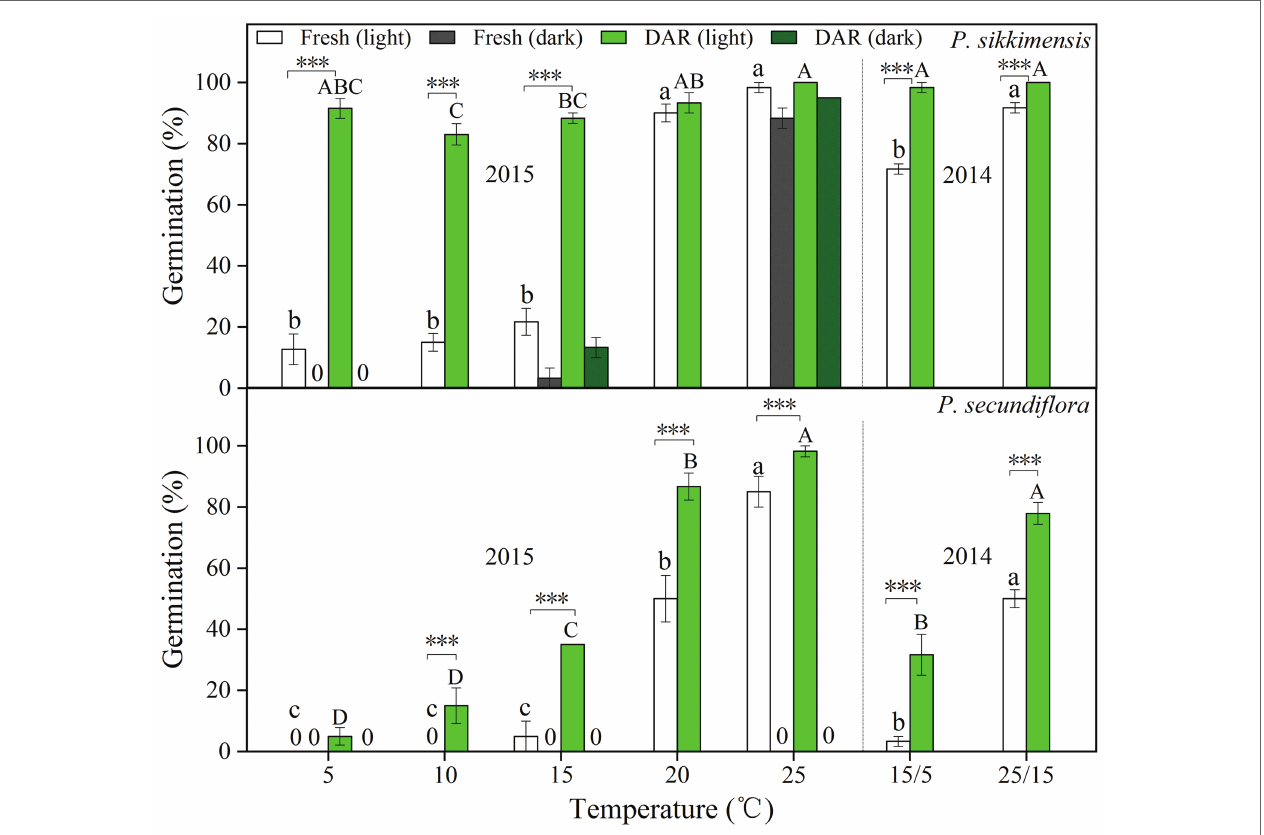
FIGURE 1 | Final germination percentages in light and dark at two alternating temperatures (15/5 and 25/15 ° C) in 2014, and five constant temperatures (5, 10, 15, 20, and 25 ° C) in 2015 for fresh and dry after-ripening (DAR) seeds of Primula secundiflora and Primula sikkimensis . Error bars indicate SE for three replicates of 20 seeds. 0, no germination with this treatment. Temperatures, dry after-ripening, and light treatments are statistically significant ( p < 0.001 by GLM) in these two species. Post hoc pairwise t -test comparisons (with Bonferroni adjustment) were carried out for each treatment. Bars with different lowercase letters differ significantly ( p < 0.05) for germination percentage of fresh seeds, and those with different uppercase letters differ significantly ( p < 0.05) for germination percentage of dry after-ripening seeds at different temperatures. ∗∗∗ Indicates significant differences ( p < 0.001) between germination percentages at the same temperature for the two treatments. The unmarked bars showed no significant difference for each